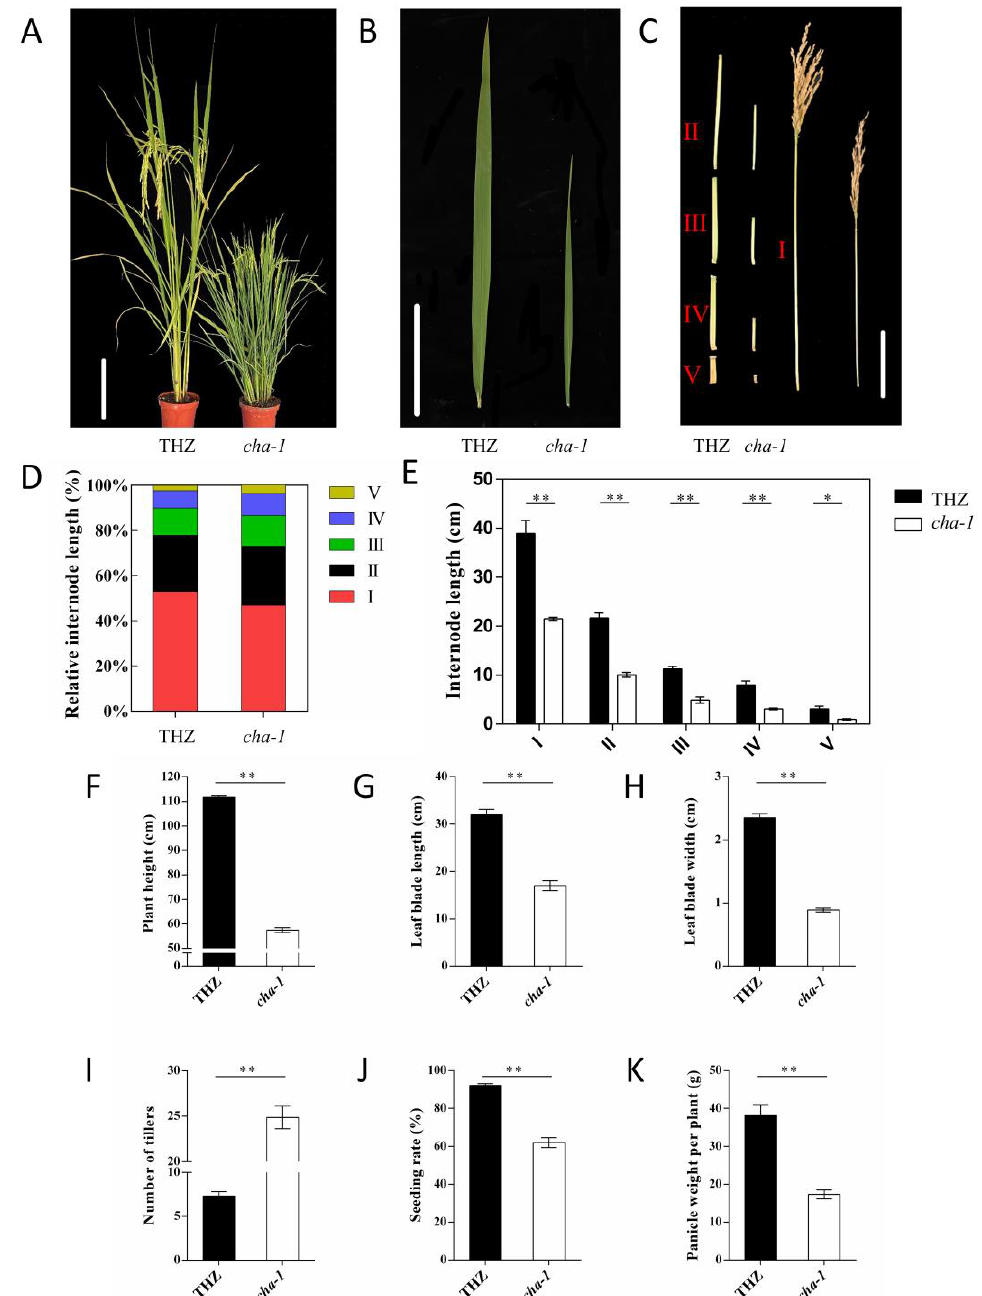
Figure 1. Morphological characteristics of THZ and CHA-1 . ( A ) Morphology of THZ and CHA-1 plants at the mature stage. Scale bar, 20 cm. ( B ) Leaf blade morphology of THZ and CHA-1 . Scale bar, 10 cm. ( C ) Internode morphology of THZ and CHA-1 . Scale bar, 10 cm. I, II, III, IV, and V represent internode I, internode II, internode III, internode IV, and internode V, respectively. ( D ) Comparison of the internode length ratio of THZ and CHA-1. ( E ) Comparison of the internode length of THZ and CHA-1. ( F ) Plant height. ( G ) Leaf blade length. ( H ) Leaf blade width. ( I ) Number of tillers. ( J ) Seeding rate. ( K ). Panicle weight per plant. Values are means ± SD. *, p < 0.05; **, p < 0.01; ns, no significance (Student’s t- test).